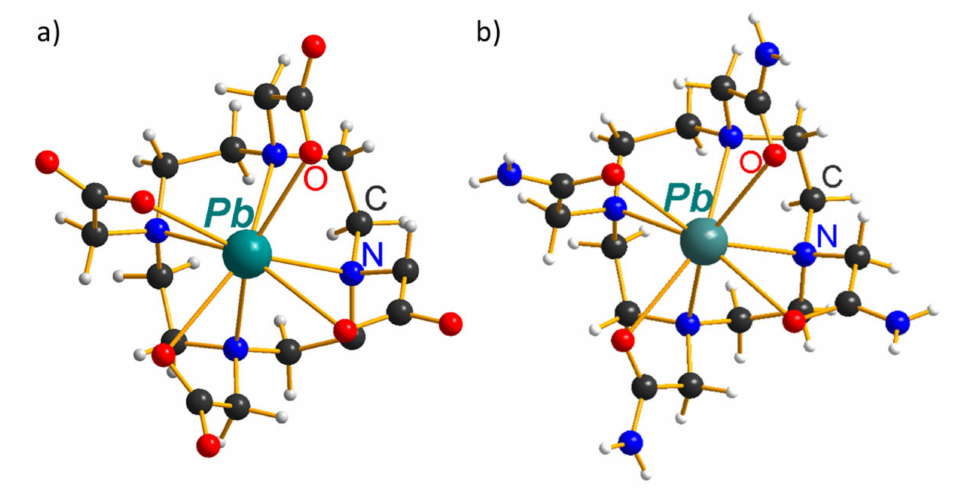
Figure 4. Crystal structure of: ( a ) Pb–DOTA; ( b ) Pb–TCMC complexes.